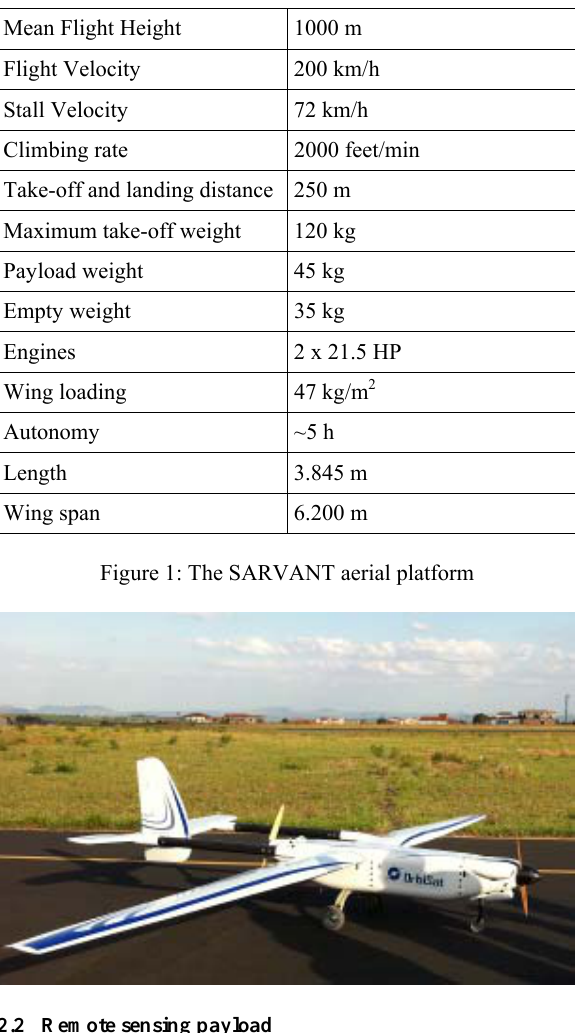
Table 1: UAV main characteristics